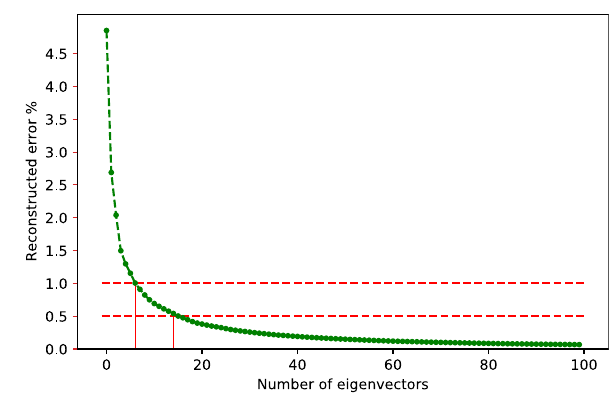
Figure 2: Mean reconstructed error as a function of the number of principal components used for the projection. The dashed lines represent the 1 and 0.5% error, respectively. For > n 17 k , the spectra can be reconstructed with more than 99.5%